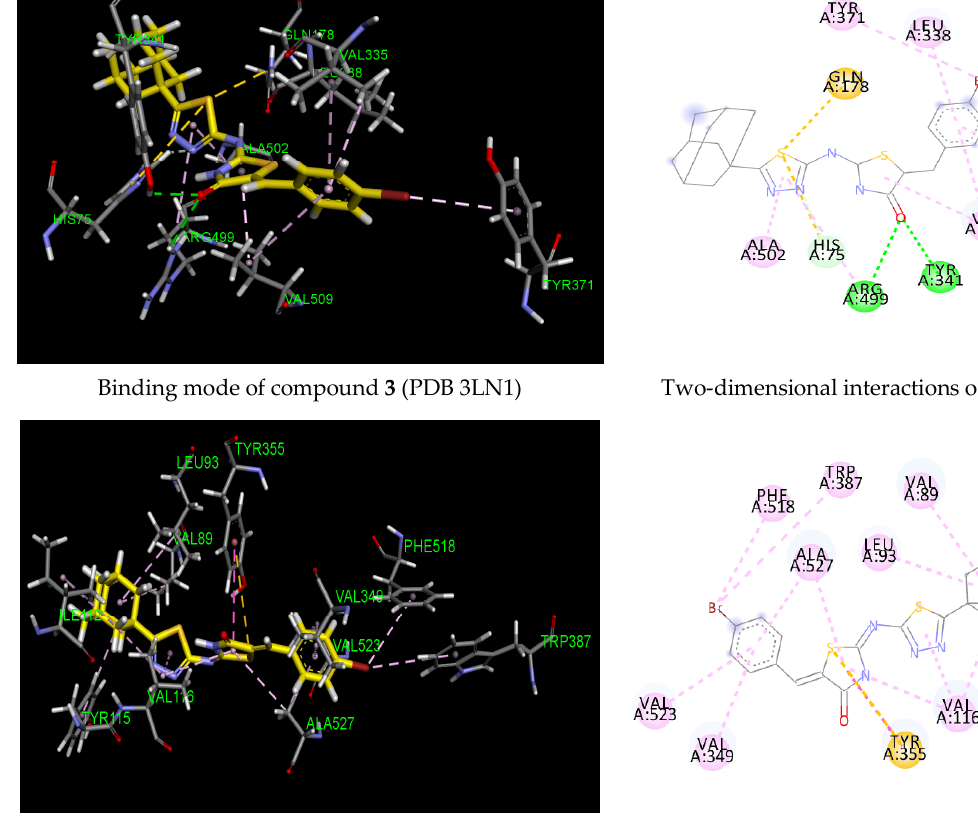
Figure 6. ( A ) Two-dimensional interaction diagram of the reference compound NDGA in 5-LOX. ( B ) Two-dimensional interaction diagram of compound 14 in 5-LOX. ( C ) Superposition of com-